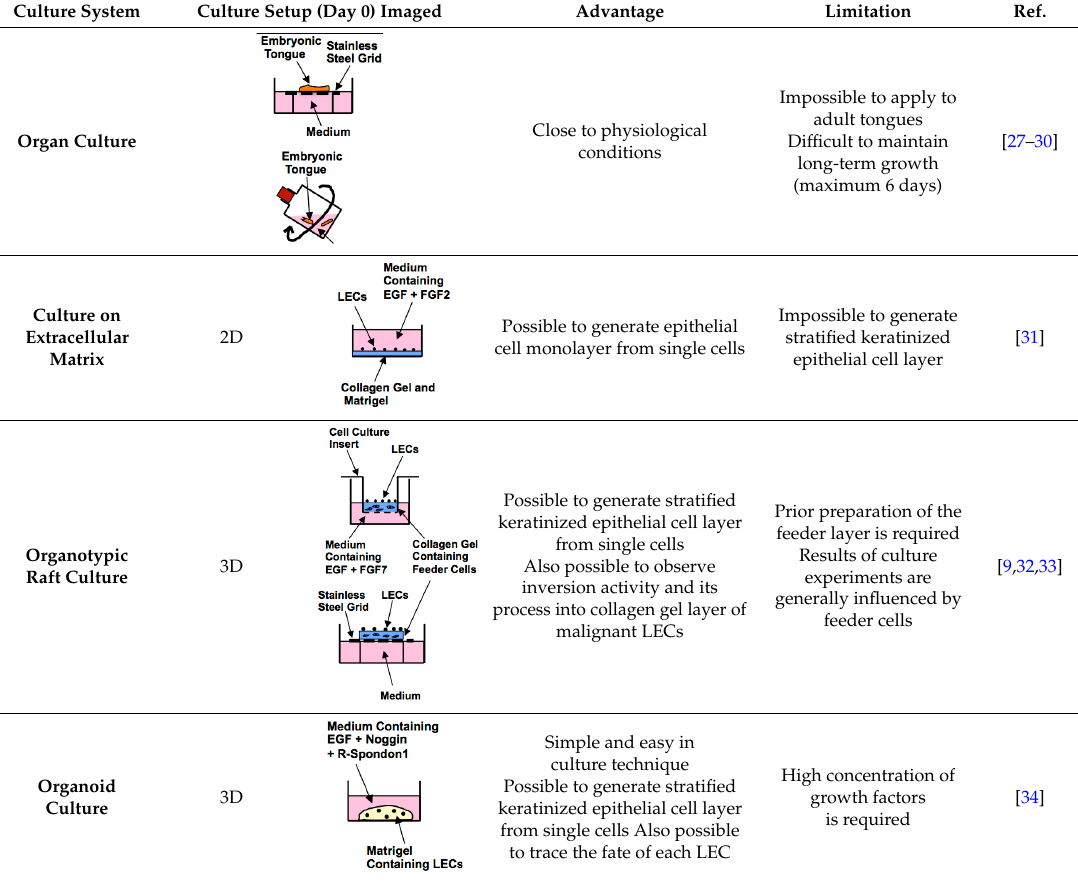
Table 2. List of lingual epithelial cell (LEC) cultures.